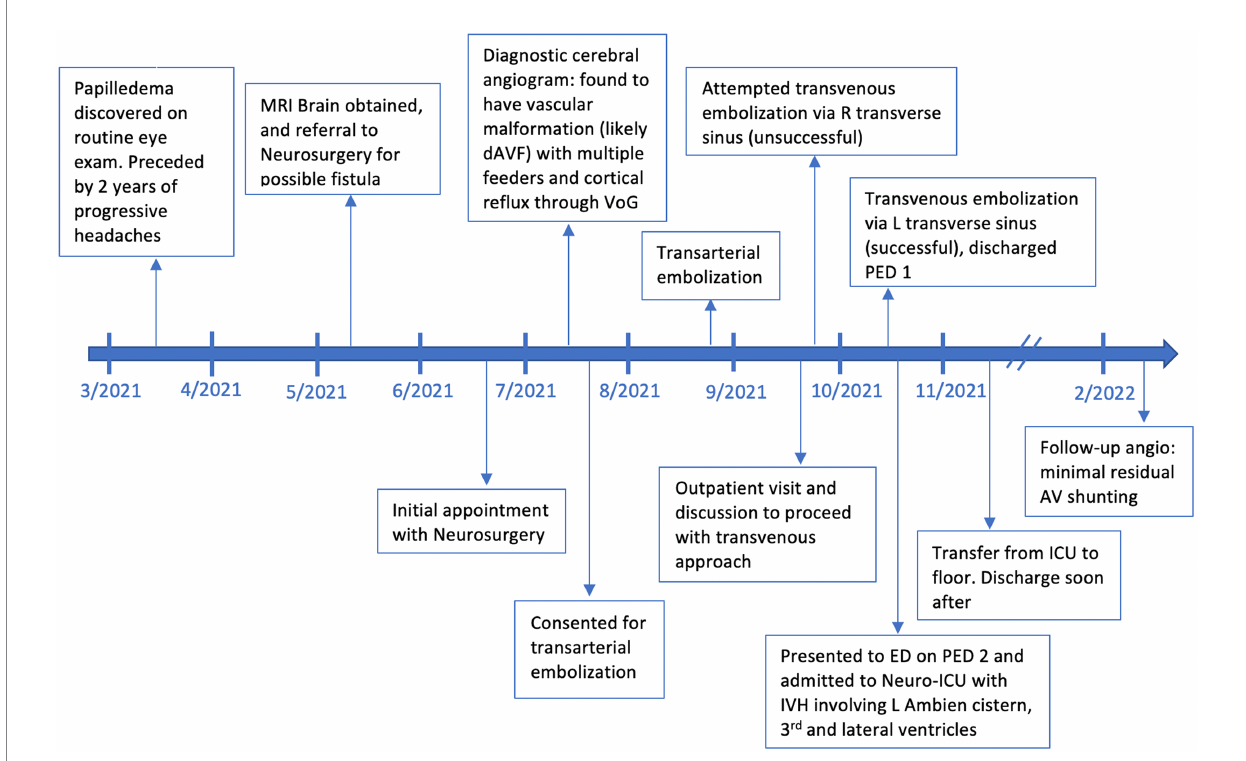
FIGURE 1 A timeline of events beginning with initial discovery of papilledema, outpatient visits related to the dAVF, angiography, embolization events, adverse events, and